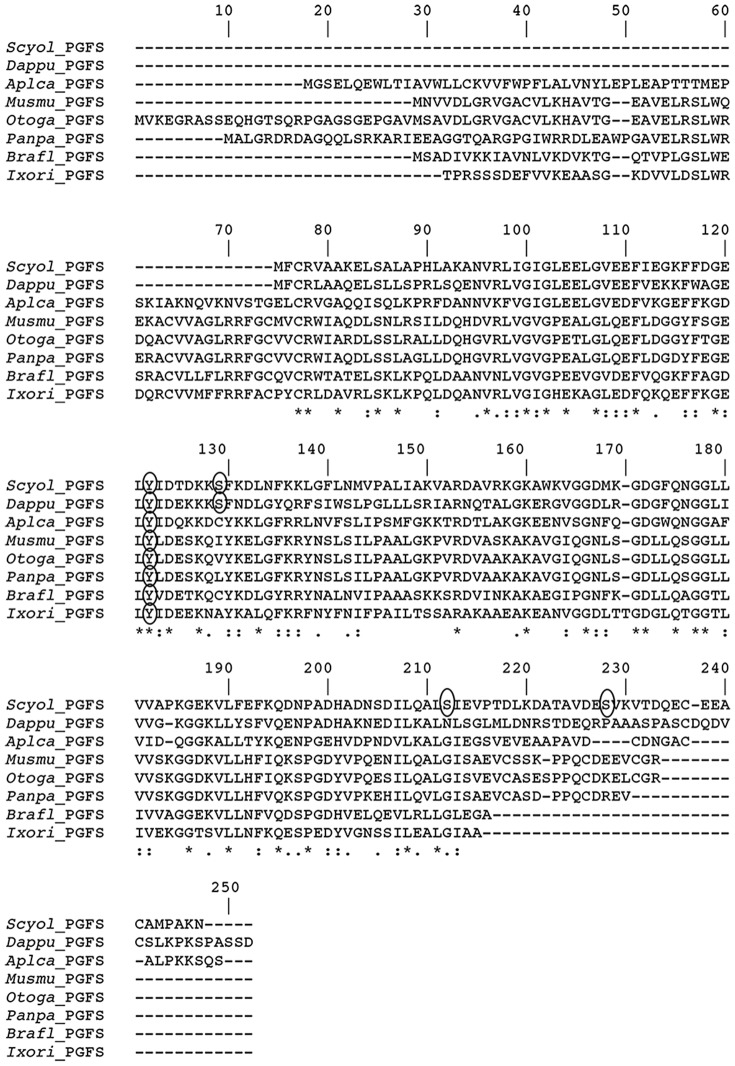
Alignment of amino acid sequence of prostaglandin F synthase (PGFS) of S. olivacea with known sequences from other species.Gaps (-) included to allow alignment. “*”: identical amino acids; “:”: conserved substitutions (same group); “.”: semi-conserved substitution (similar shapes). Circles indicating phosphorylation site prediction on protein sequences. (Scyol, Scylla olivacea), mud crab; (Otoga, Otolemur garnettii), greter galago (Accession number XP_003793364); (Musmu, Mus musculus) Mouse (NP_079858); (Panpa, Pan paniscus), bonbono (XP_003807368); (Brafl, Branchiostoma floridae), lancelet (XP_002587381); (Ixori, Ixodes ricinus), castor bean tick (JAA72765); and (Dappu, Daphnia pulex), water flea (EFX68017).